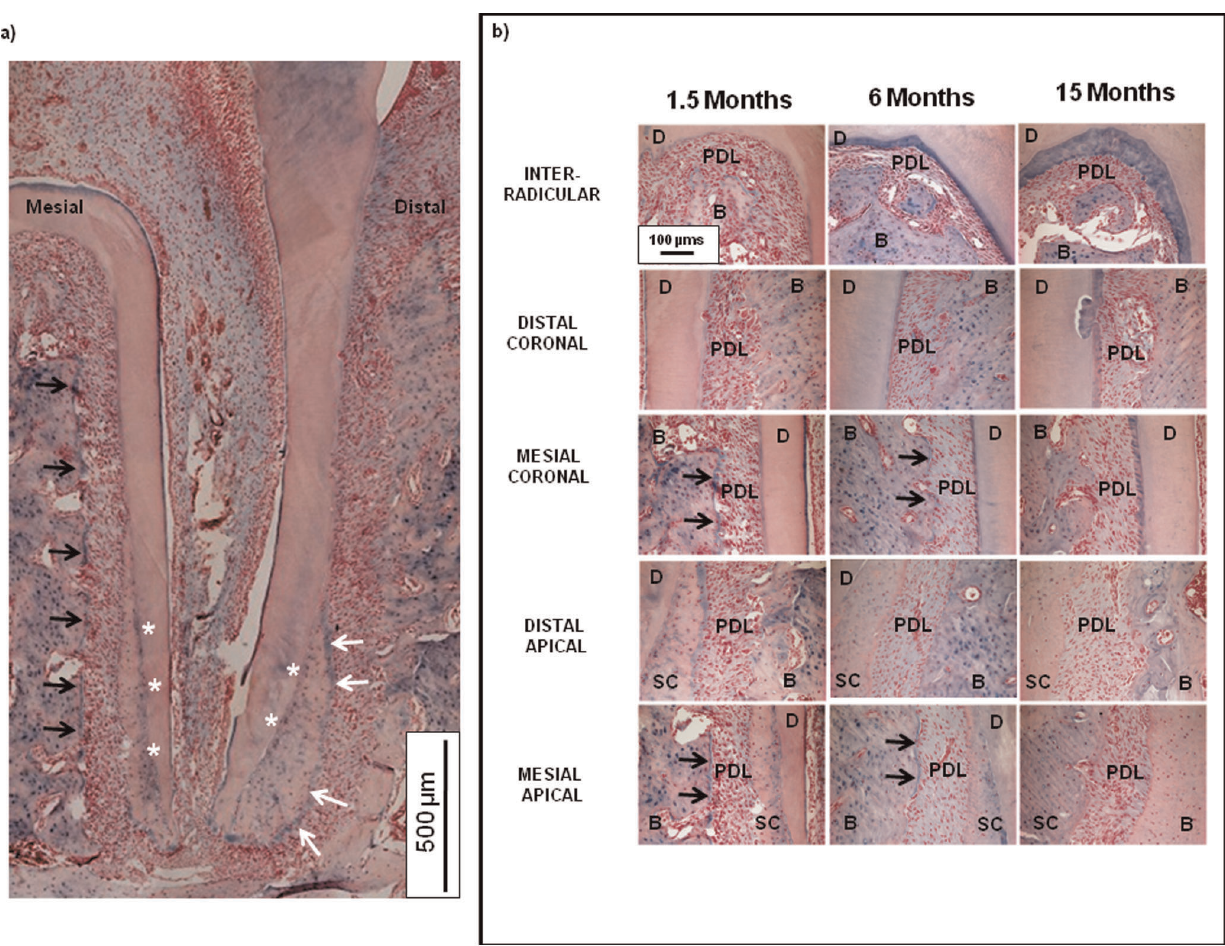
Figure 4. Localization of sulfated GAGs using alcian blue stain. a) Light micrographs at 10X of alcian blue with nuclear fast red counterstain indicates more sulfated GAGs on the mesial aspect as indicated by black arrows (shown here in a 1.5 month old rat), as well as around osteocytes in the alveolar bone, precementum (white arrows) and cementum dentin junction (white asterisks). We also observed staining to occur in dentin. Scale bars=500 m m. b) Corresponding age-related changes at interradicular, coronal-apical, and mesial-distal entheses regions showed decreased alcian blue staining and lost mesial specificity with age (black arrows). Scale bars=100 m m.